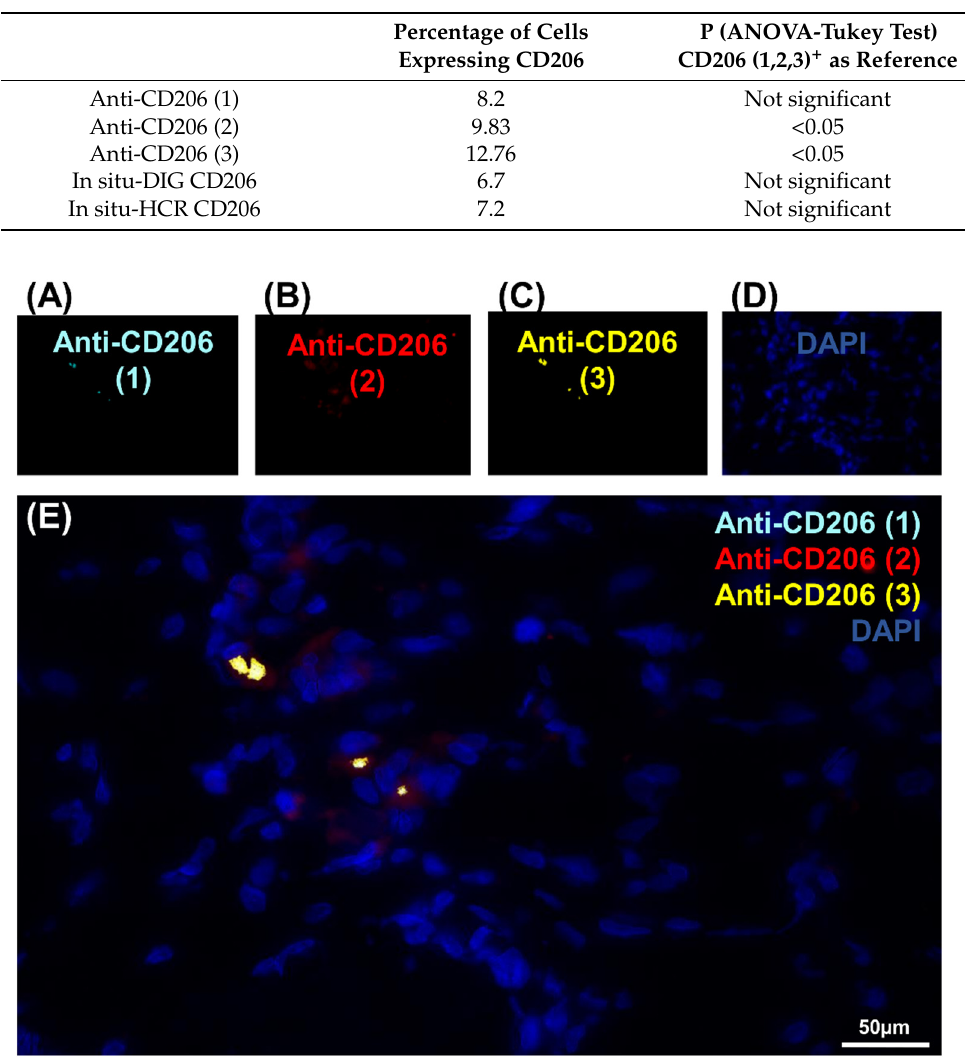
Figure 2. Negative controls of the CD206 marker expression in cells in IR-ASC muscle by immuno-fluorescence method. ( A ) Negative control of Figure 1A with Anti-CD206 (1) (Alexa488, turquoise fluorescence). ( B ) Negative control of Figure 1B with Anti-CD206 (2) labeling (Alexa488, red fluorescence). ( C ) Negative control of Figure 1C with Anti-CD206 (3) labeling (Alexa488, yellow fluorescence) labeling. ( D ) Negative control of Figure 1D with nuclear staining with DAPI (blue fluorescence). ( E ) Merged image.